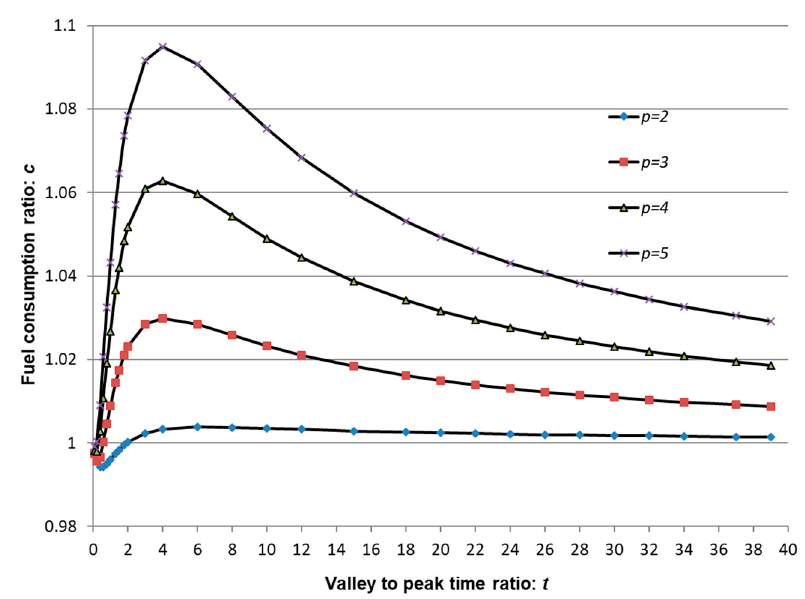
Figure 7. Fuel consumption ratio comparison ( η = 0.85 , r = r r ).